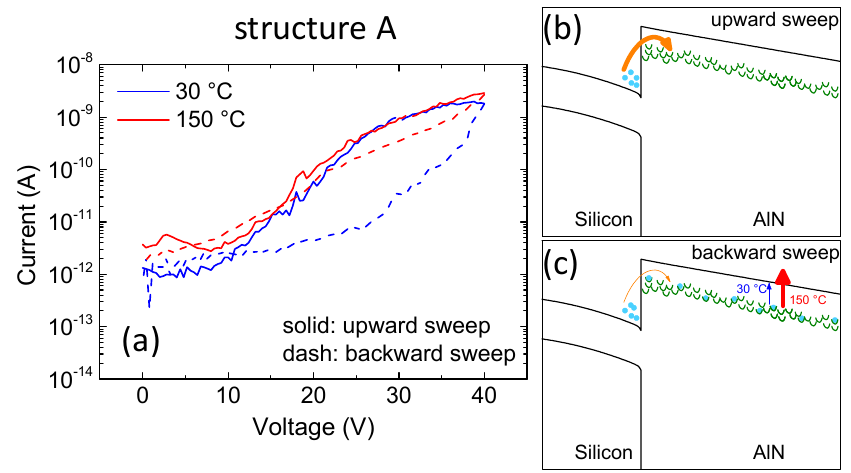
Figure 6. ( a ) Double sweep (upward: solid, backward: dashed) current-voltage characterization on sample A at both room and high temperature. ( b , c ) represent a schematic band diagram during the upward sweep and the backward sweep, respectively.